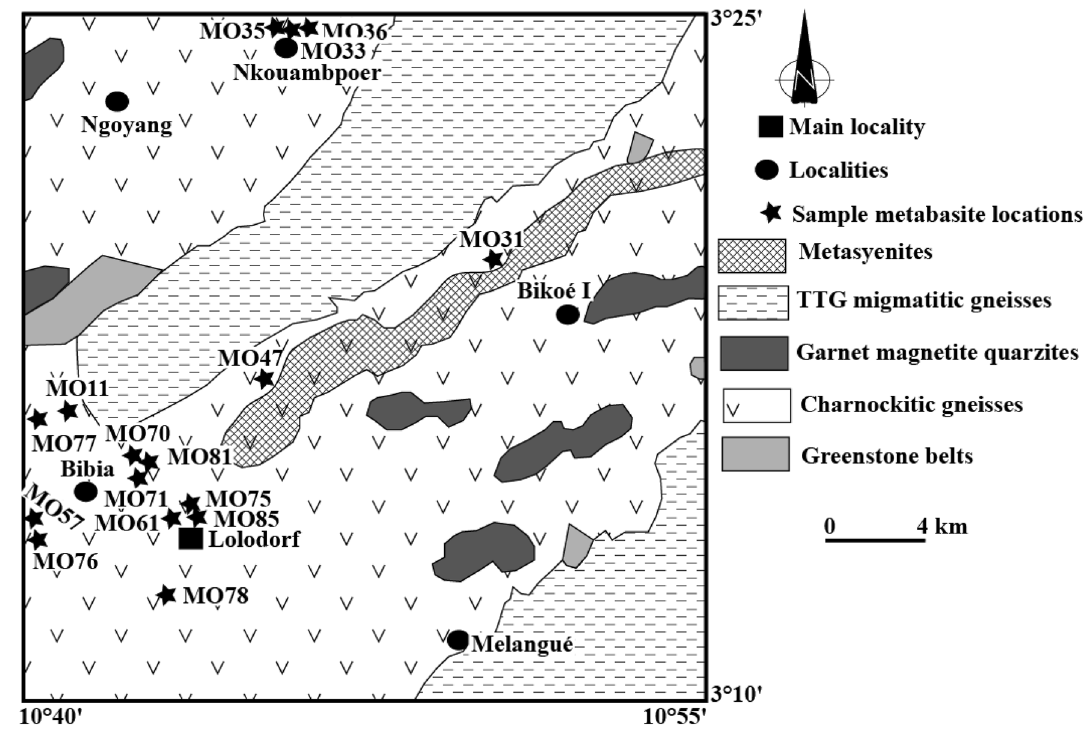
Fig. 2 Schematic map of the studied area modified after [20, 21, 37]. (Sample locations are represented by